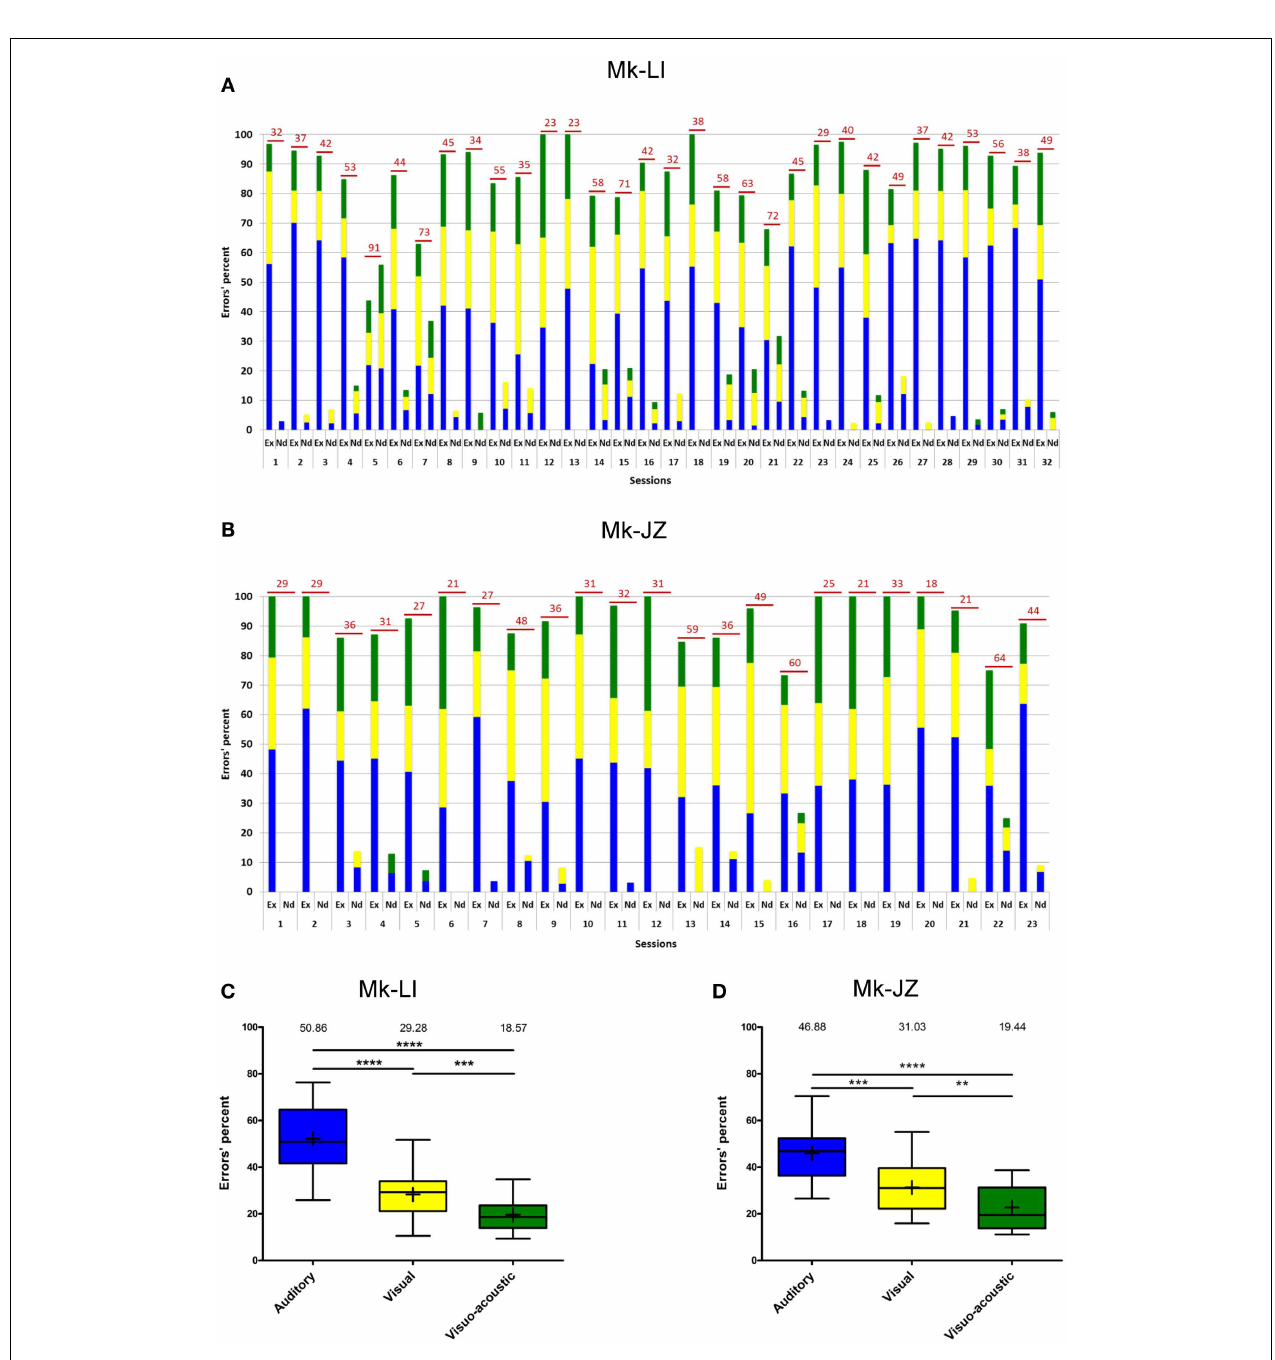
in (A,B) were distributed in the form of box and whisker plots (C,D) .The end of the whiskers represented maxima and minima.The Mann–Whitney test showed p -values results as ** when p < 0.01, *** when p < 0.001 and **** when p <